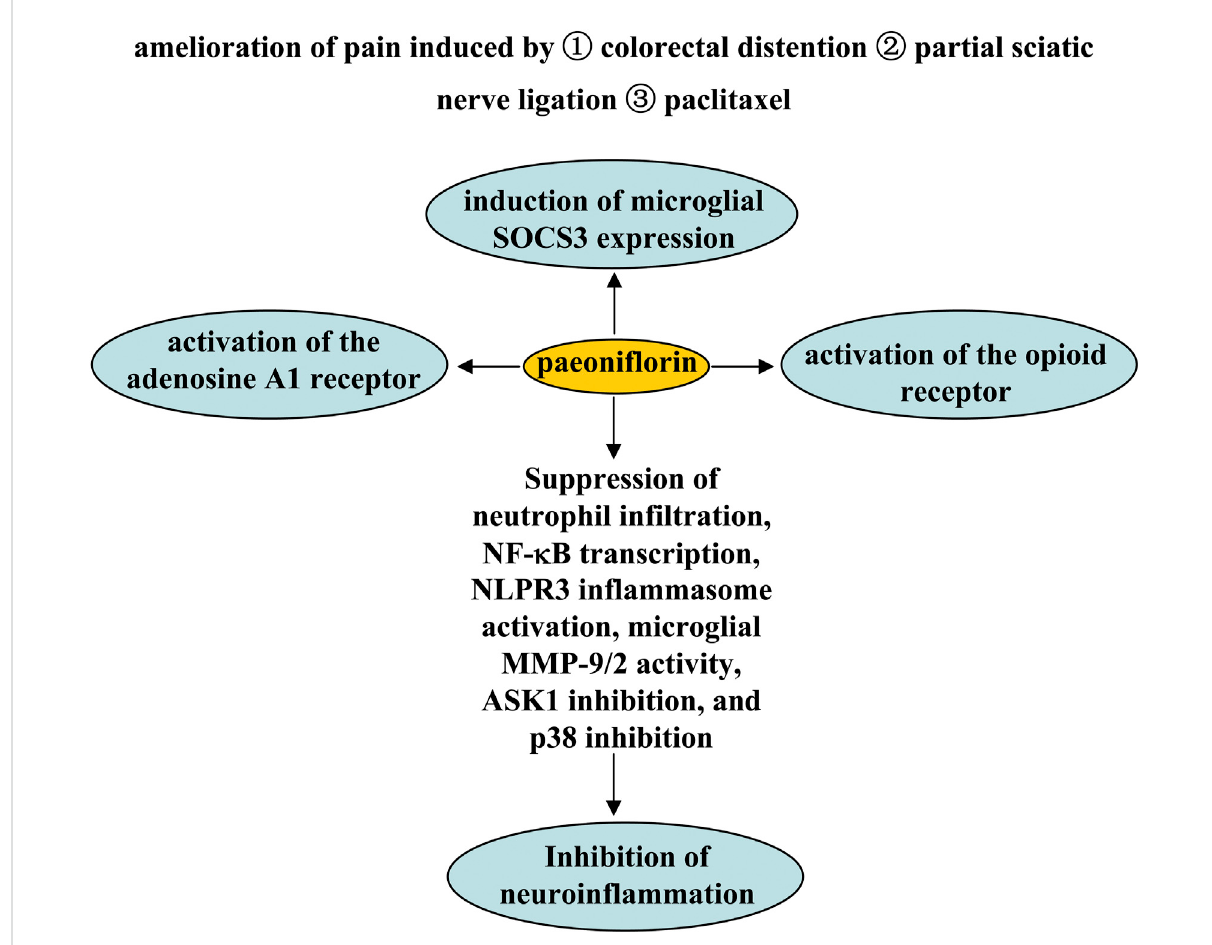
Effects and mechanisms of paeoni fl orin on pain. Administration of paeoni fl orin may relieve pain induced by colorectal distention partial sciatic nerve ligation, or paclitaxel. Mechanisms such as adenosine A1 and opioid receptor activation, induction of microglial SOCS3 expression, and inhibition of neutrophil in fi ltration, NF- κ B transcription, NLPR3 in fl ammasome activation, microglial MMP-9/2 activity, ASK1 inhibition, and p38 inhibition may mediate the analgesic effect of paeoni fl